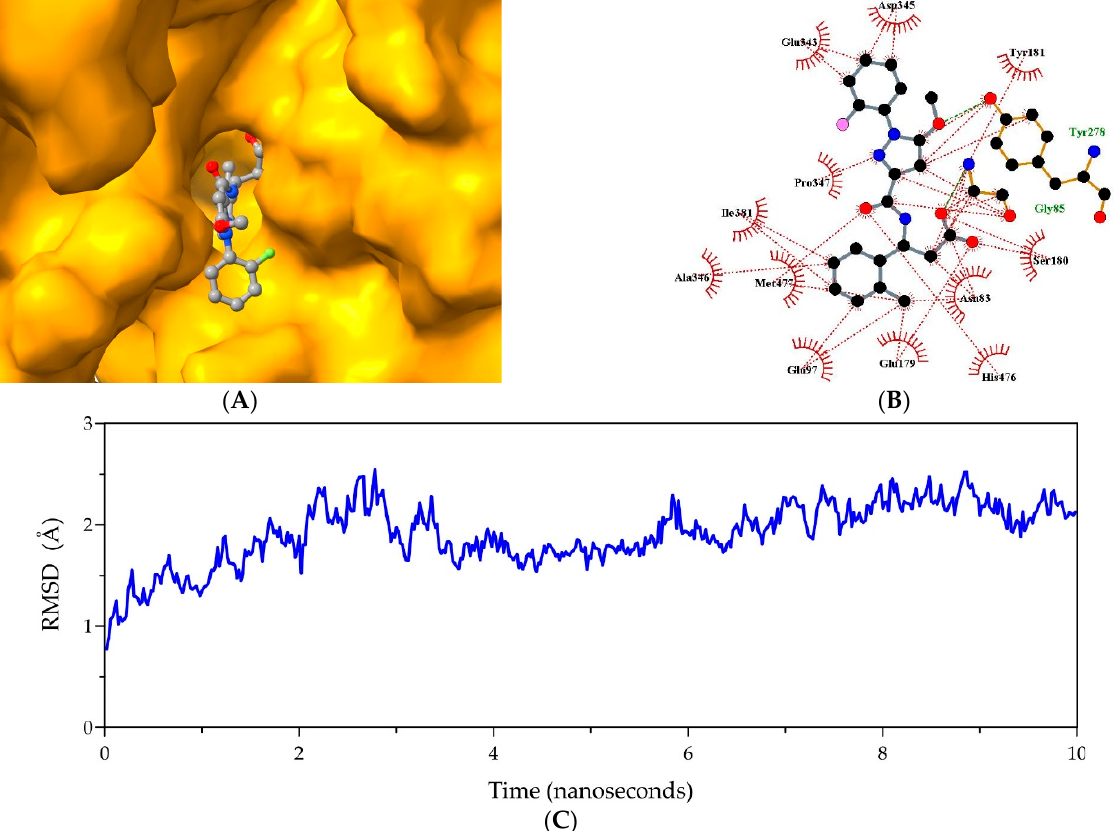
Figure 4. Structural analyses of the Nf 314-2a complex. ( A ) Illustration of the best binding pose of Nf 314 (orange surface) and compound 2a (balls/sticks colored by the element). ( B ) 2D representation of the Nf 314-2a non-covalent interaction network. Colors: hydrogen bonds, green dashes; hydrophobic interactions, red dashes/arcs; carbon, black; oxygen, red; nitrogen, blue; fluorine, pink; ligand bonds, gray; protein bonds, orange. ( C ) Depiction of the root mean square deviations (RMSDs) trajectory, colored in blue, during MD simulations performed to assess the Nf 314-2a complex